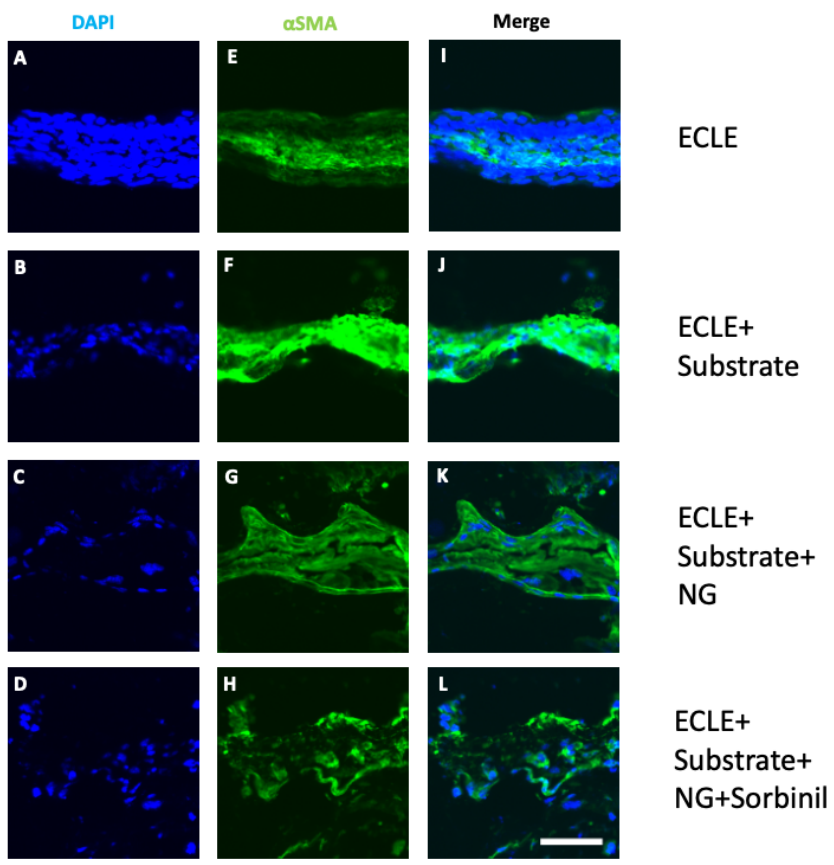
Figure 3. Postsurgical immunofluorescence staining for α SMA in mouse lens capsule. Capsular bags were recovered 5 days following surgery. Treatment groups included surgery only (ECLE, panels A , E , I ), ECLE with naked substrate (panels B , F , J ), ECLE with nanogel-coated substrate (panels C , G , K ), and ECLE with substrated coated with Sorbinil-eluting nanogel (panels D , H , L ). Images are representative of three separate experiments. Signals were generated after staining for nuclei with DAPI (panels A – D ) and for α SMA (panels E – H ). Panels ( I – L ) show merged signals. Scale bar is 50 μ m.